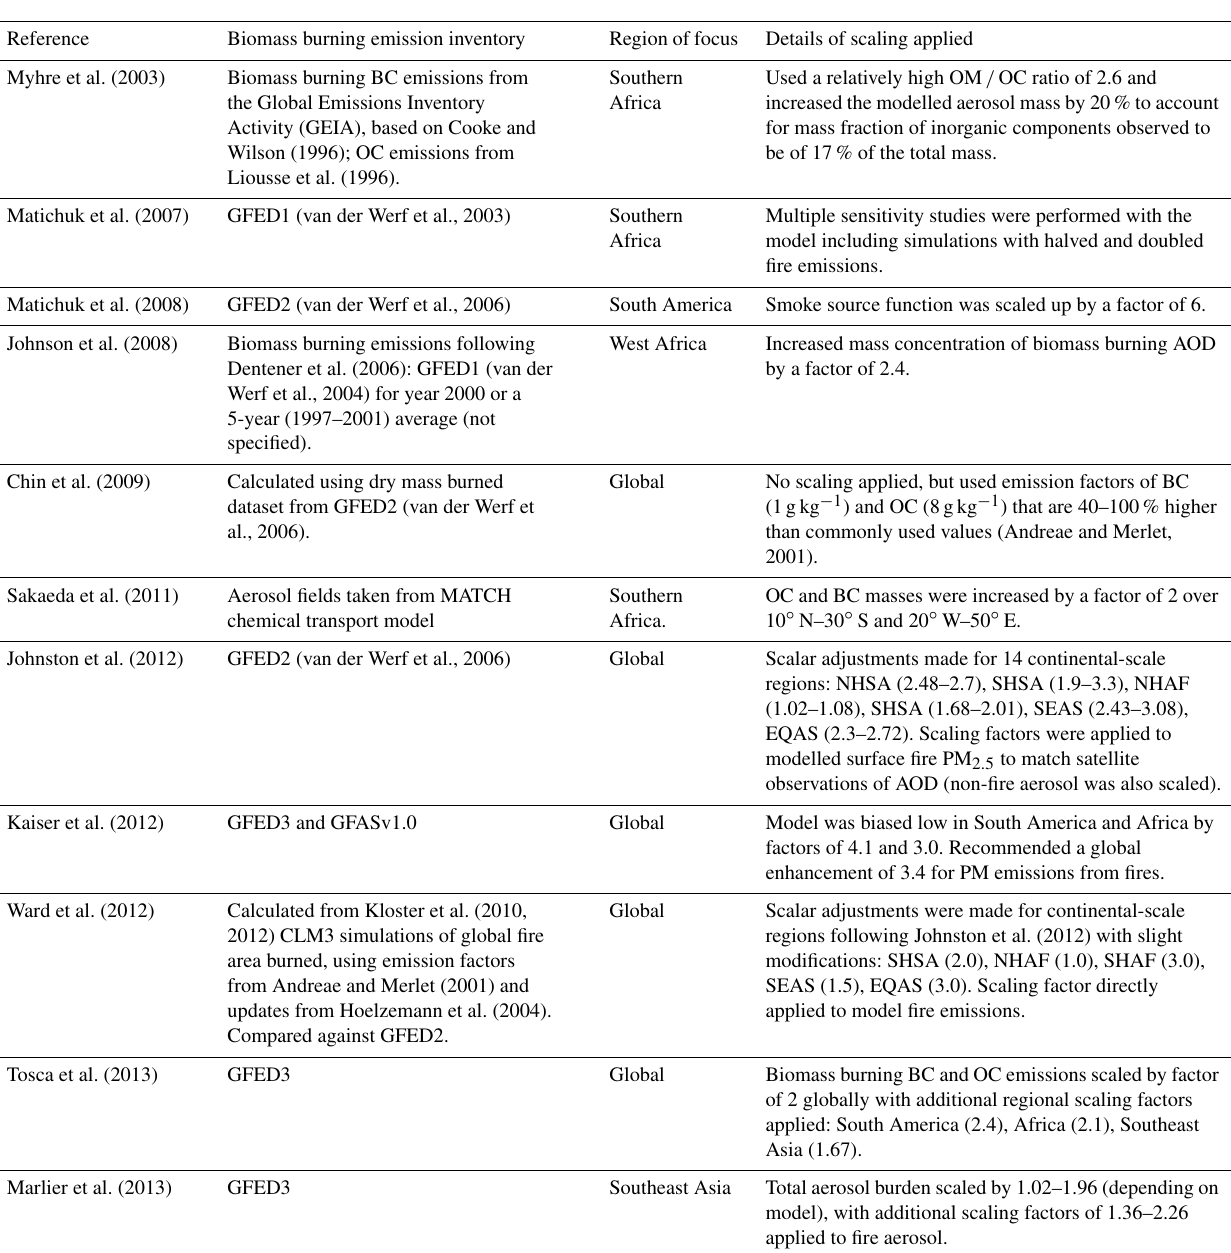
Table 2. Summary of scaling factors applied in previous modelling studies to biomass burning emissions or modelled concentrations of biomass burning aerosol to match observations. Region abbreviations used in the table are defined in van der Werf et al. (2006): Northern Hemisphere South America (NHSA), Southern Hemisphere South America (SHSA), Northern Hemisphere Africa (NHAF), Southern Hemi- sphere Africa (SHAF), Southeast Asia including the Philippines (SEAS) and equatorial Asia (EQAS). See van der Werf et al. (2006, 2010) for discussion of differences between GFED versions 1, 2 and 3; on average GFED3 is 13% lower than GFED2 van der Werf et al. (2010), with total GFED2 emissions lower than GFED1 in Central and South America and southern Africa (van der Werf et al.,